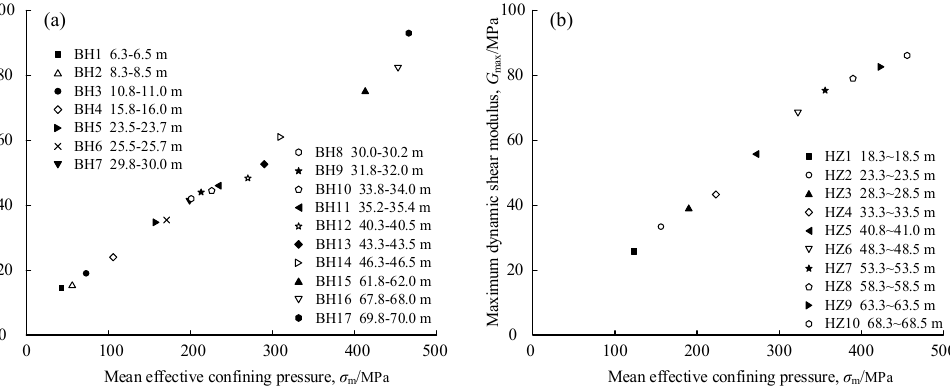
Figure 4. Experimental results of RC tests on marine clay from Hangzhou Bay: ( a ) variation of dynamic shear modulus with shear strain; ( b ) variation of damping ratio with shear strain.